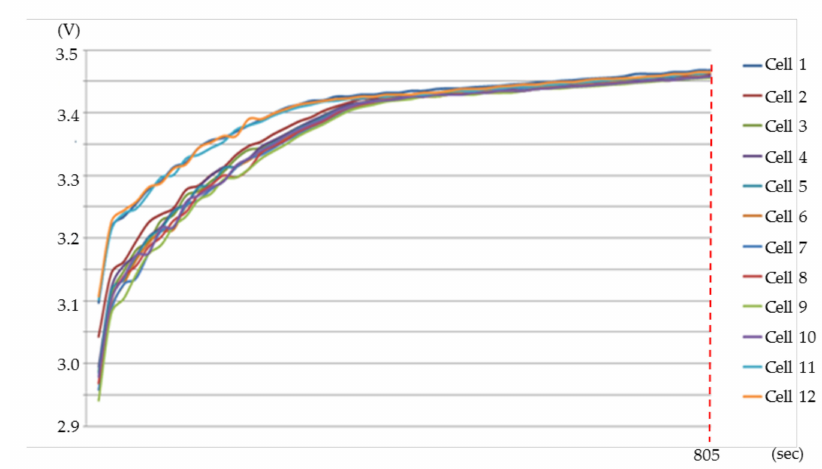
Figure 8. Charging curve measured by LTC6803.